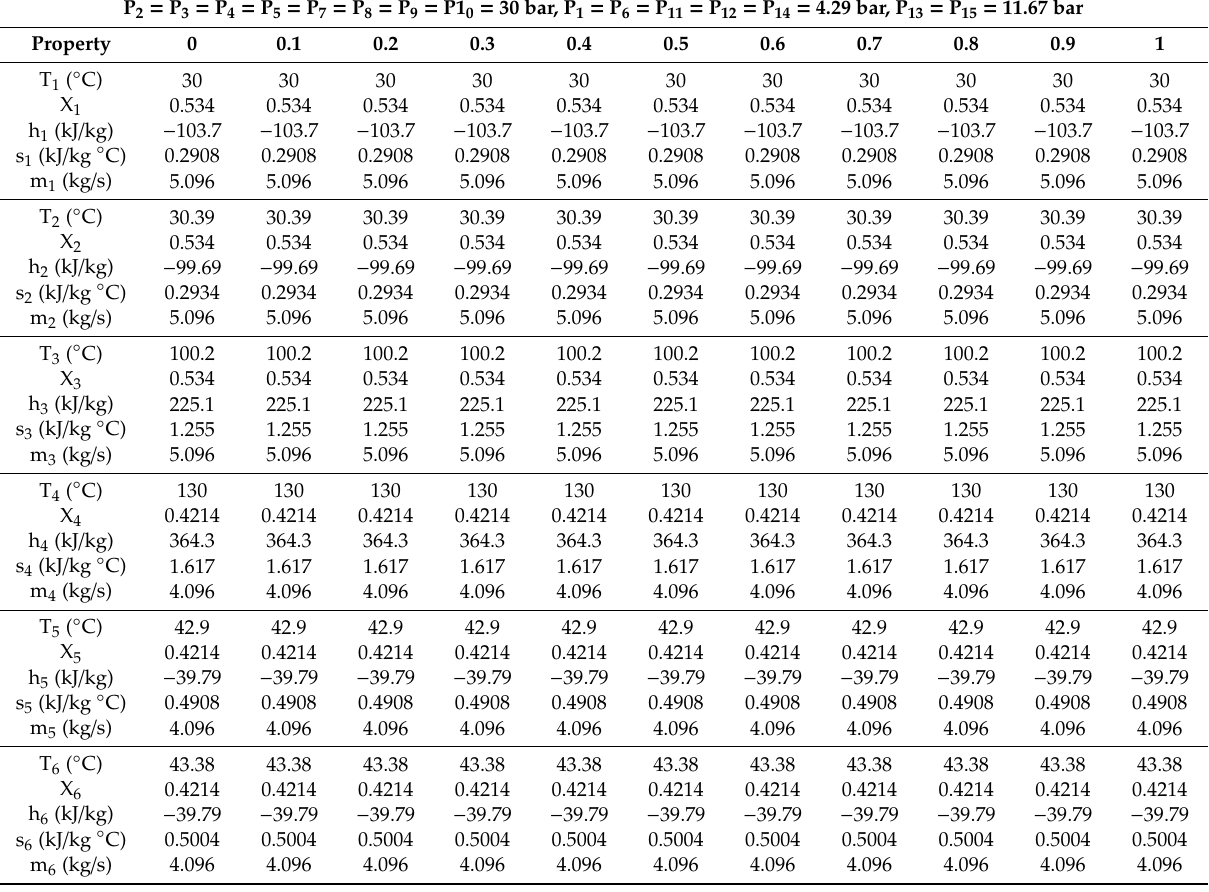
Table A1. Simulation data for the case base of Model